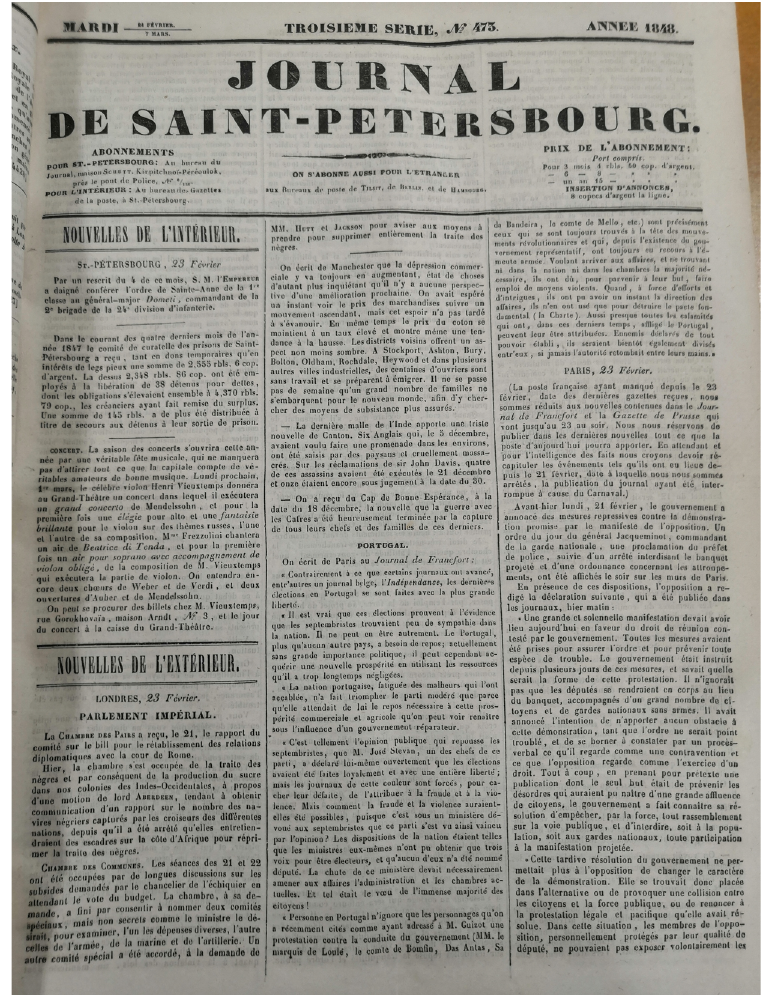
Fig. 1 Example of an issue. Journal de St.-Pétersbourg , no. 473 (24 February/7 March 1848), National Library of Finland. Photo: Heidi